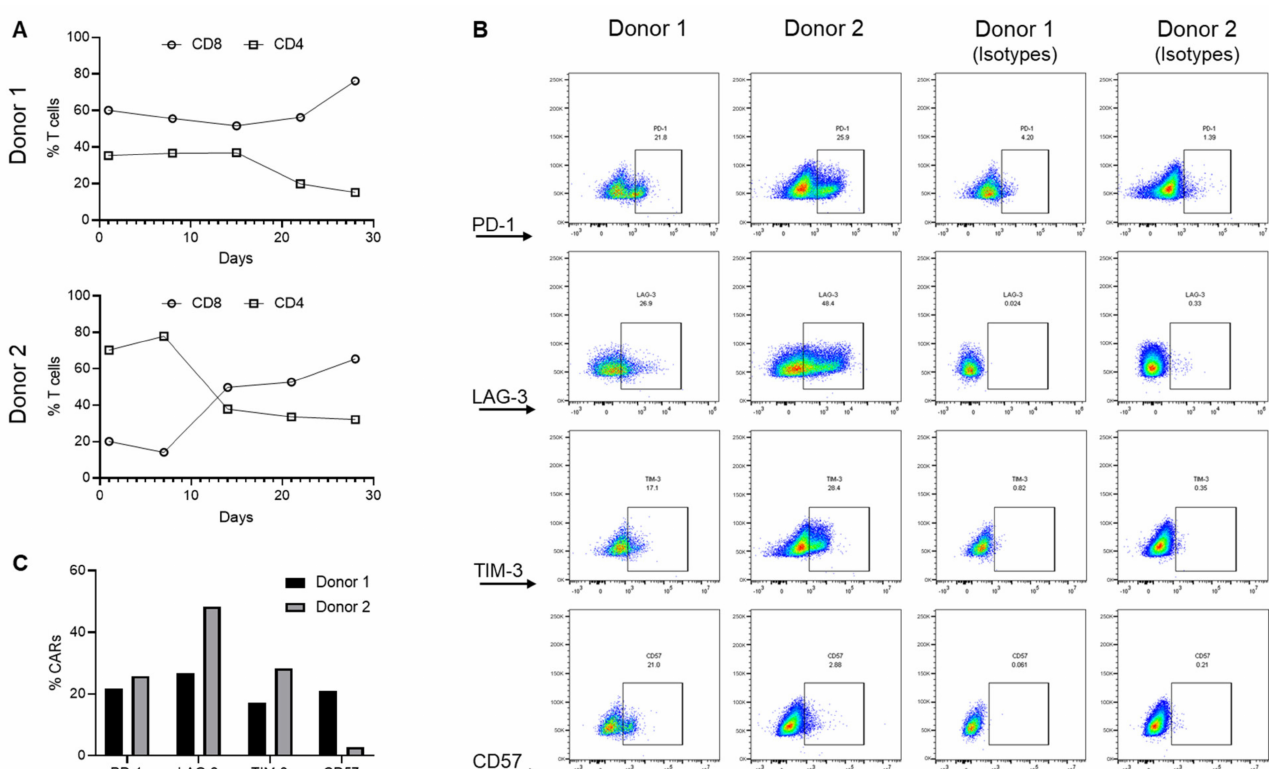
Figure 3. Donor lineage skewing and the expression of exhaustion markers. ( A ) Changes in CD8 and CD4 cells during ex vivo expansion of EGFRvIII CAR T cells. ( B , C ) Expression of T cell exhaustion (PD-1, TIM3, and LAG3) and senescence (CD57) markers on CAR T cells. These data summarize the analysis generated from two different donors (Donor 1 and Donor 2) and are representative of a triplicate